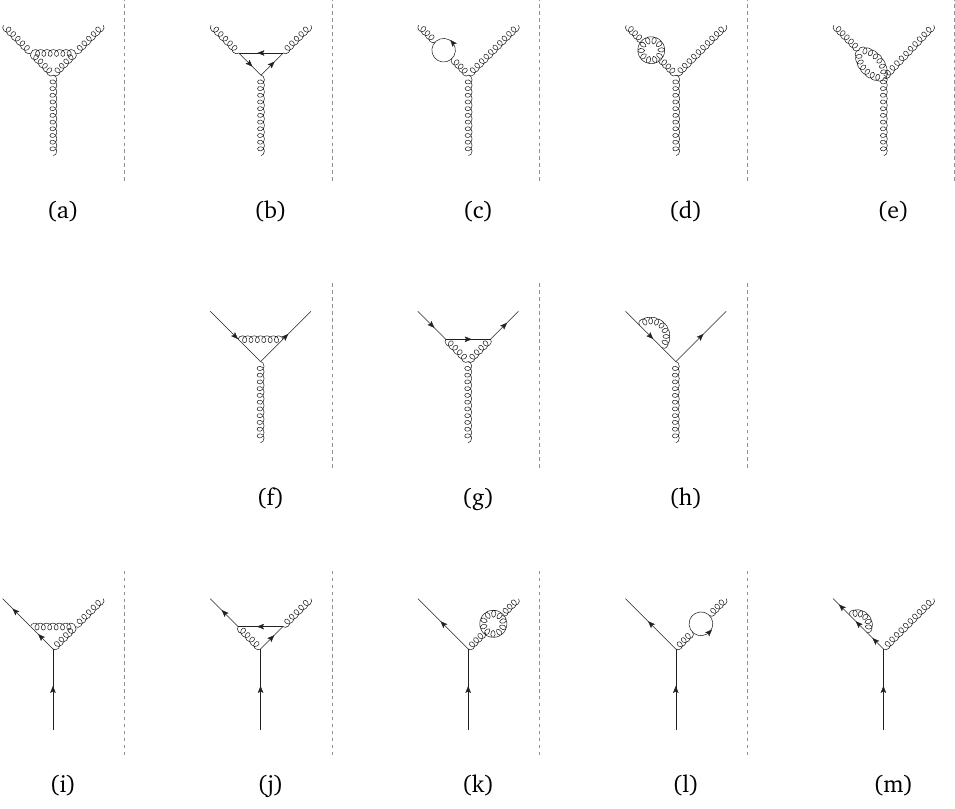
Figure 3: Virtual graphs for the amplitude in LO channels. The tree graphs in the complex conjugate amplitude are not